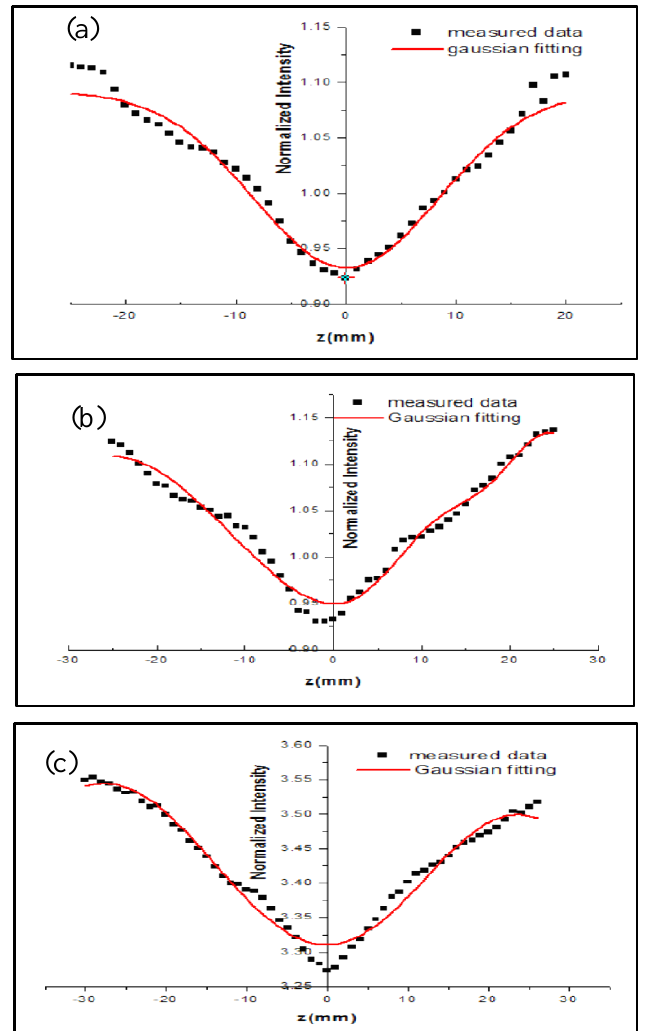
Fig.3: The far-field OA Z-scan curves of the three crude samples illuminated by He-Ne laser pulses at 632.8nm. (a) B sample, (b) K1 sample, and (c) K2